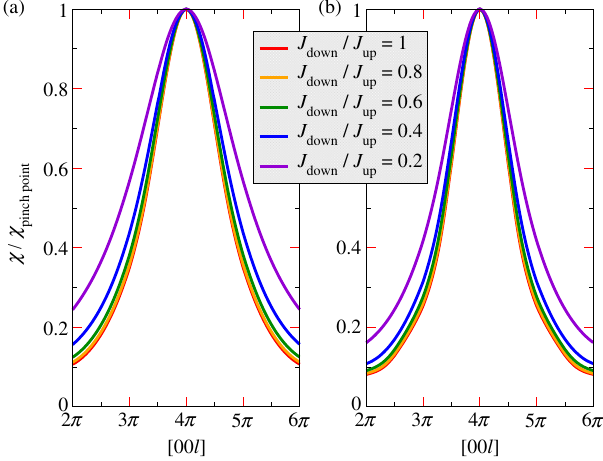
FIG. 12. For the breathing nearest-neighbor Heisenberg antiferromagnet, we plot the susceptibility along the 1D cut (see the white line in the T=J 1 ¼ 1 = 100 panel in Fig. 6) at the lowest simulated temperature T=J 1 ¼ 1 = 100 for (a) S ¼ 1 = 2 and